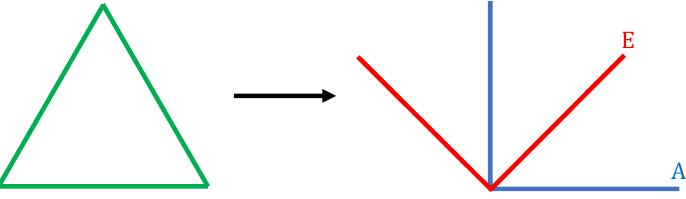
Figure 3. Transition from one cluster to two effective interferometers. The blue one shows the A -mode, and the red one shows the E -mode. The effective interferometers have a 90 ◦ arm angle, and the E -mode is rotated by 45 ◦ from the A